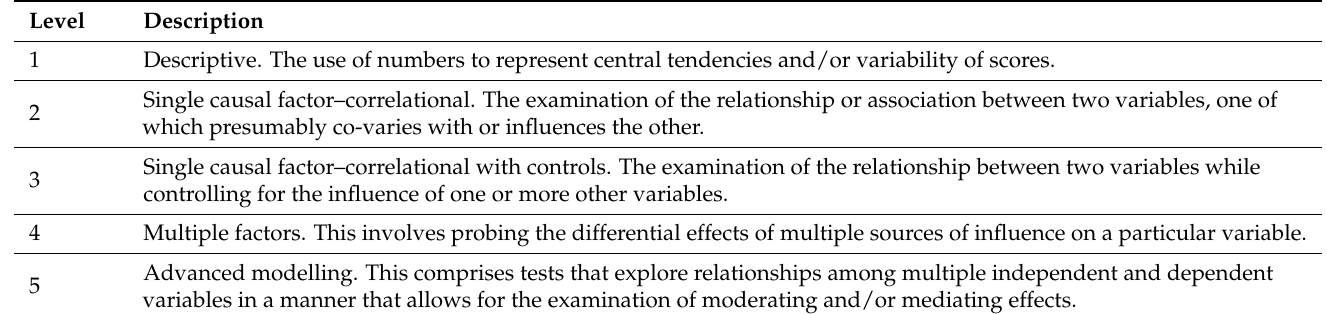
Table 3. Modified Descriptions of Five Statistical Levels from Hallinger (2011).